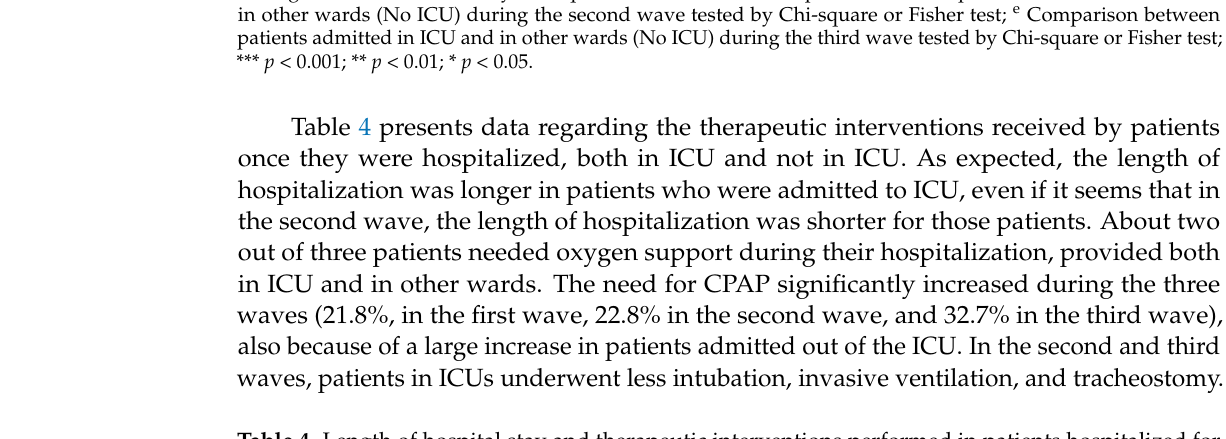
Table 4. Length of hospital stay and therapeutic interventions performed in patients hospitalized for SARS-CoV-2, in intensive care unit (ICU), and other wards (No ICU), stratifying by